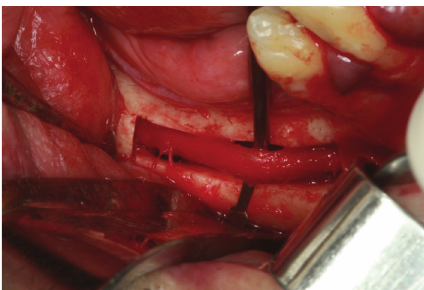
Figure 29: Inferior alveolar nerve positioned.